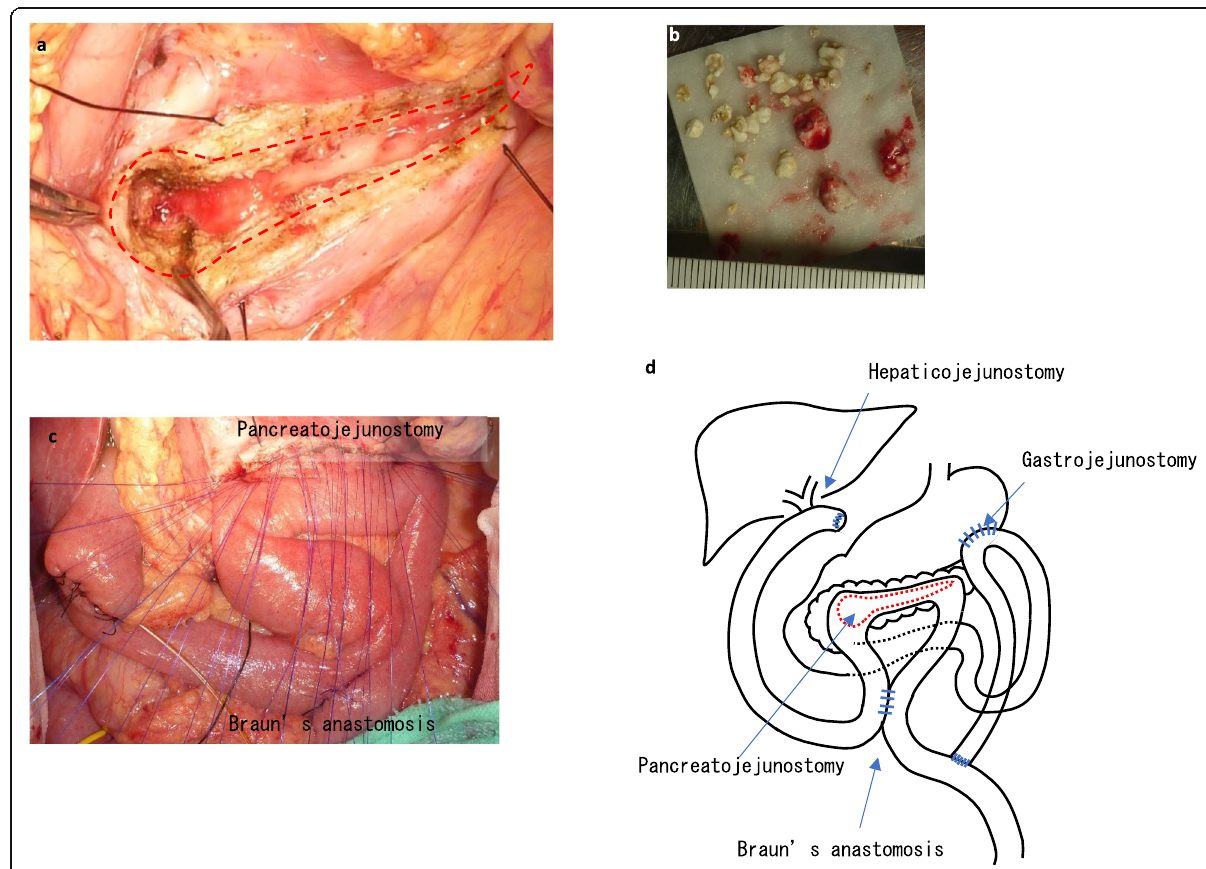
Fig. 4 Operative findings. We made a longitudinal incision along the main pancreatic duct and excised the pancreatic head ( a ). Many pancreatic stones were removed from the pancreatic duct ( b ). After hepaticojejunostomy, we performed pancreatojejunostomy with a side-to-side anastomosis ( c ). After pancreatojejunostomy, Braun ’ s anastomosis was placed, and gastrojejunostomy was performed ( d